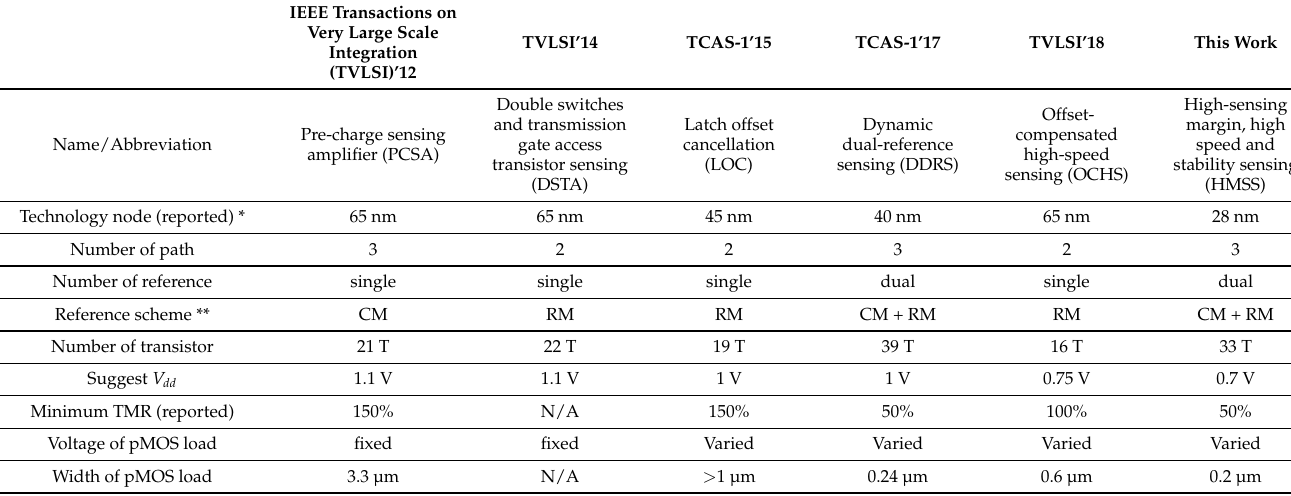
Table 2. Qualitative comparison of different sensing